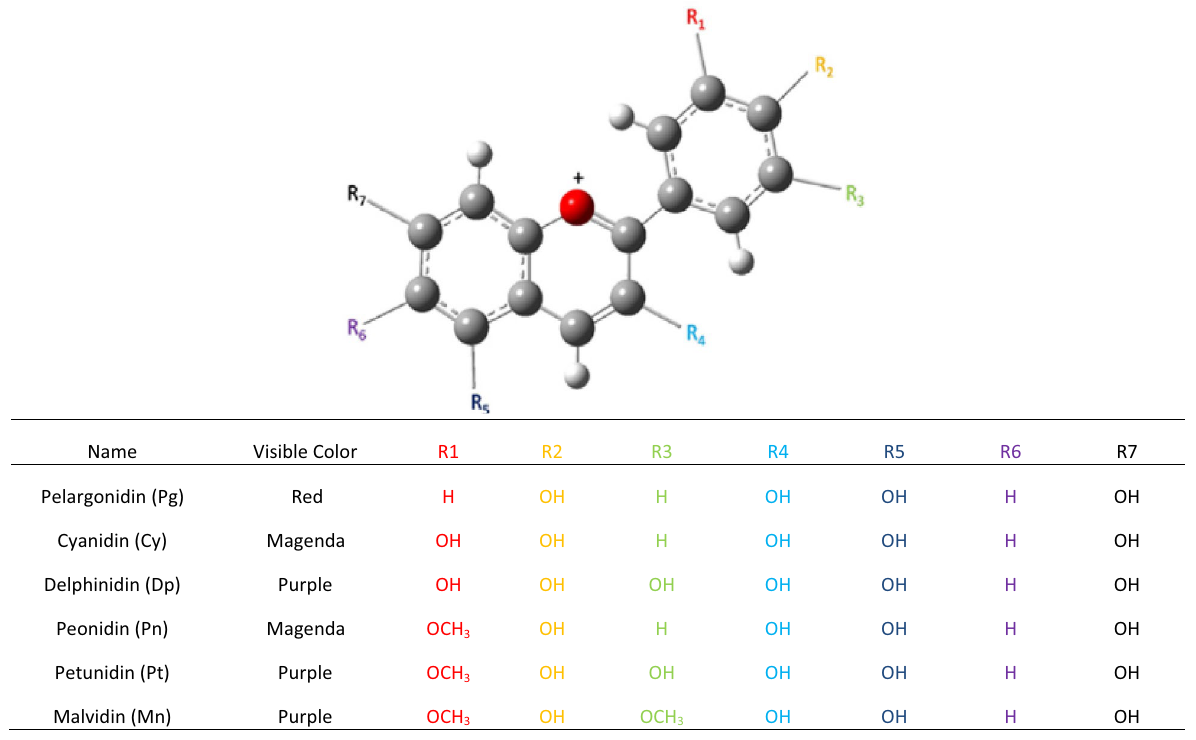
dependent on the dye 3